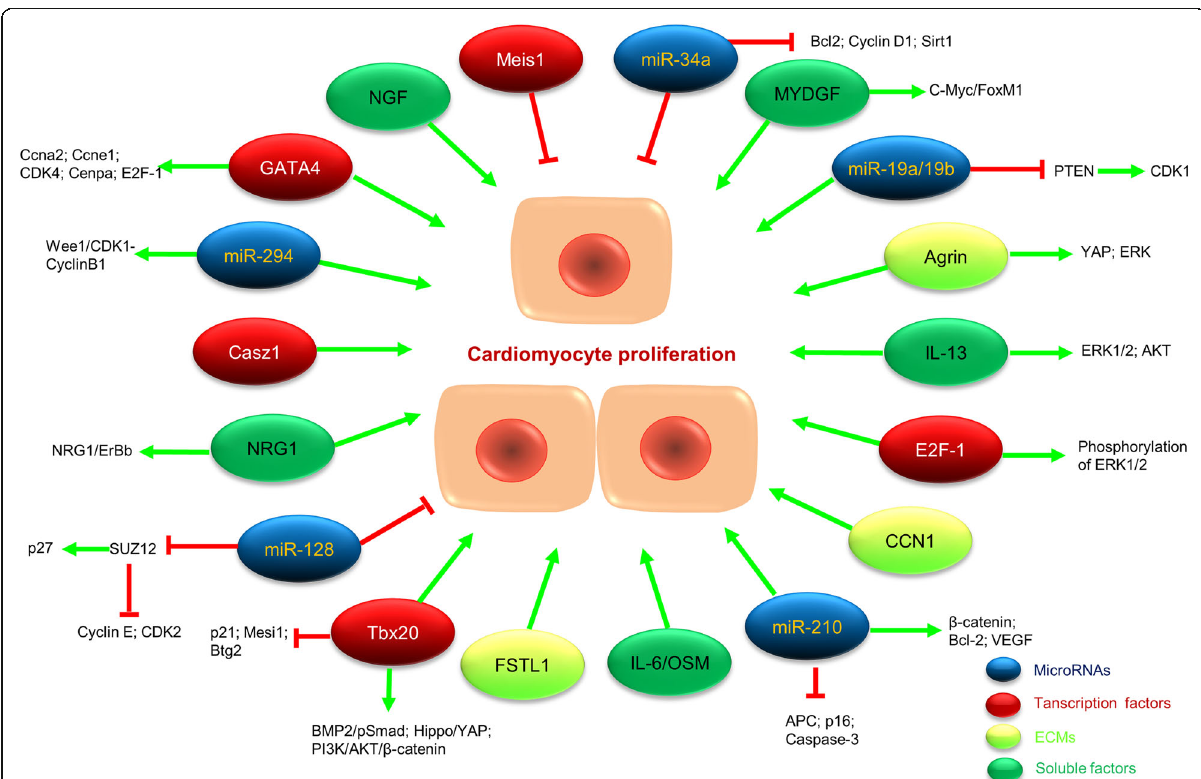
Fig. 4 Major factors that target cardiomyocyte proliferation and their possible molecular pathways. Green arrows indicate that cardiomyocyte proliferation or gene expression is promoted, and red solid lines indicate that cardiomyocyte proliferation or gene expression is inhibited. Bcl-2: B- cell lymphoma-2; Btg2: B-cell translocation gene 2; BMP2: bone morphogenetic protein-2; Ccna2: cyclin A2; Ccne1: cyclin E1; Cenpa: centromere protein A; CDK1/2/4: cyclin-dependent kinase 1/2/4; C-Myc: cancer MYC; E2F-1: FoxM1: forkhead box protein M1; pSmad: phosphorylated mothers against DPP homolog; PTEN: phosphatase and tensin homologue deleted on chromosome 10; p27/ p21/ p16: cyclin-dependent kinase inhibitor; SUZ12: suppressor of Zeste 12 homolog; Sirt1: Sirtuin 1; VEGF: vascular endothelial growth factor; Wee1: G2 checkpoint